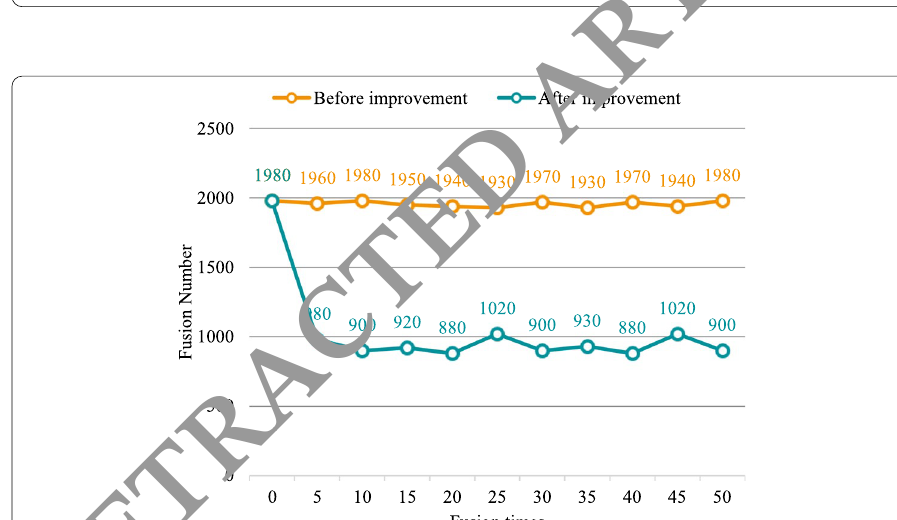
Fig. 5 Data fusion algorithm transmission time